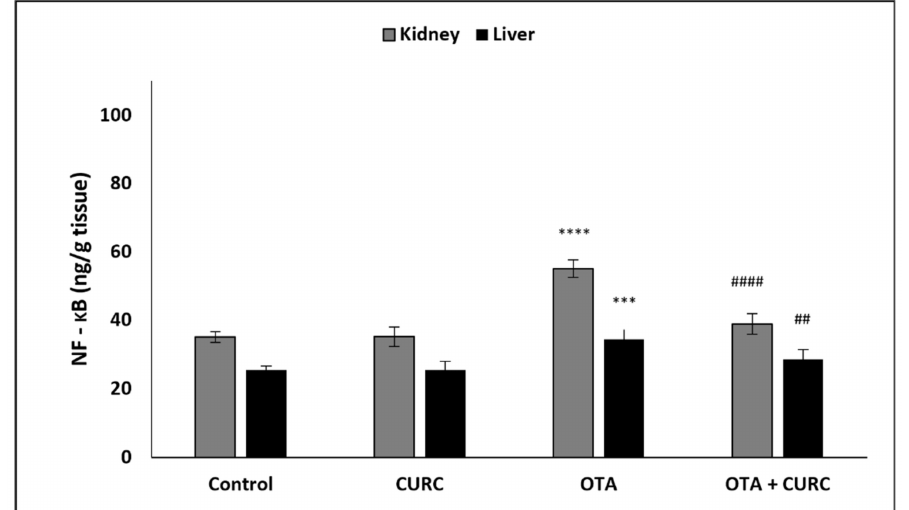
Figure 4. Effect of curcumin (CURC) on kidney and liver nuclear factor-kappa B (NF–kB) level in different experimental groups after 14 days of treatment. Control group; CURC group (100 mg/kg b.w. of CURC); OTA group (0.5 mg/kg b.w. of OTA); OTA + CURC group (0.5 mg/kg b.w. of OTA plus 100 mg/kg b.w. of CURC). Data are expressed as mean ± standard deviation (SD) of n = 6 rats in each group (*** p < 0.001 and **** p <0.0001 vs. control; ## p < 0.01 and #### p < 0.0001 vs.